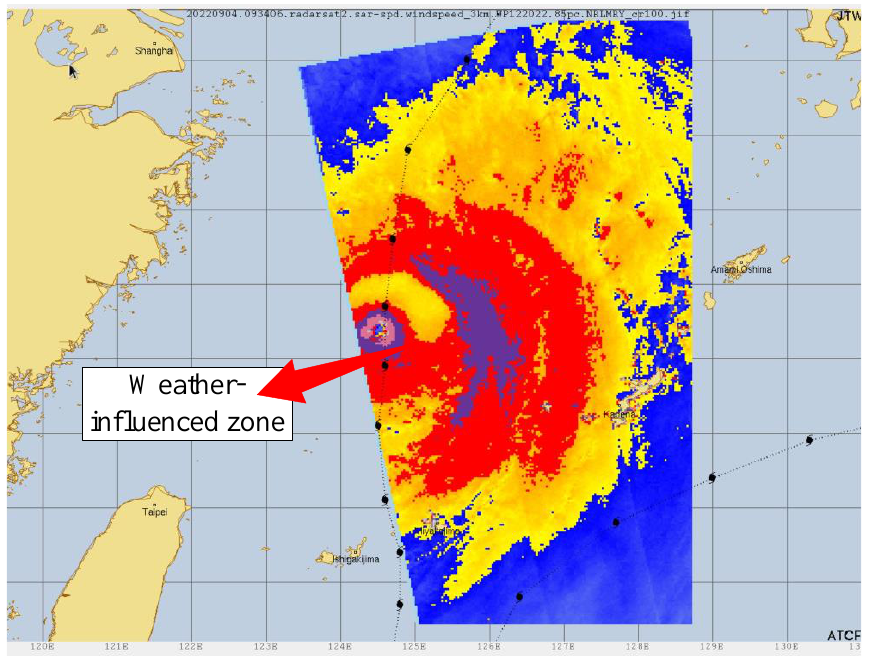
Figure 4. Weather-influenced airspace (typhoon near Okinawa, Japan).